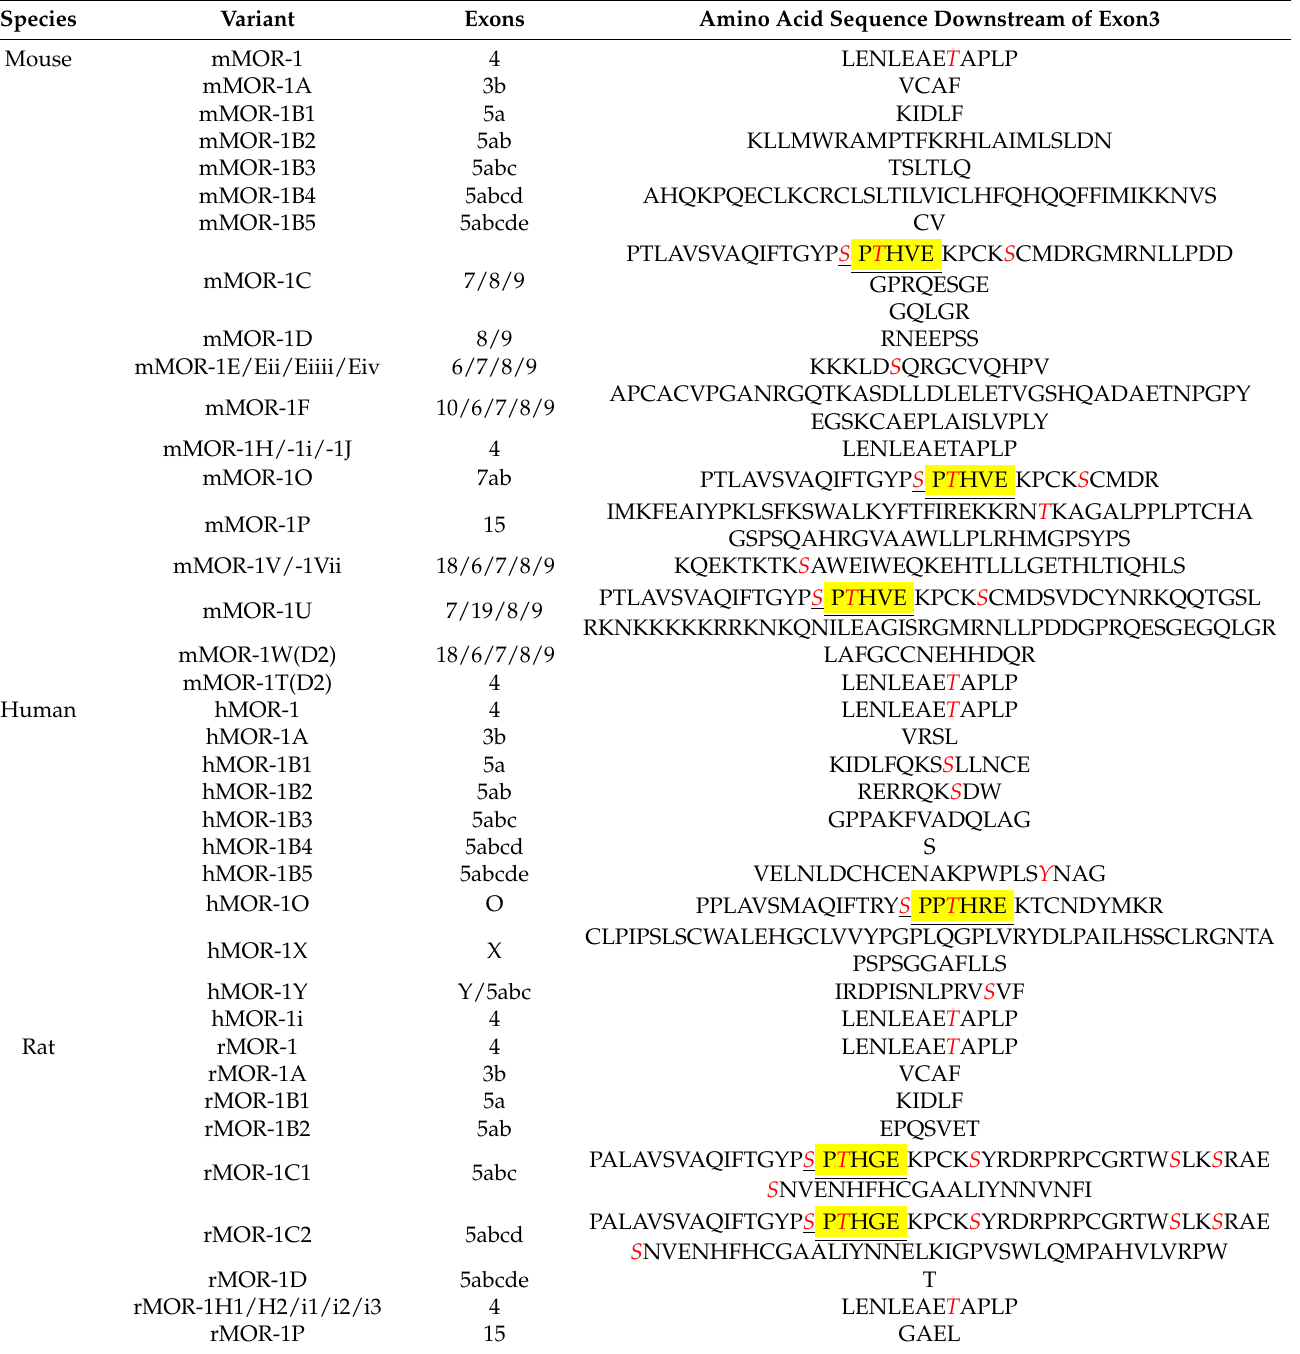
Table 2. Amino acid sequences of encoded by alternative exons downstream of exon 3 in 7TM C-terminal variants.